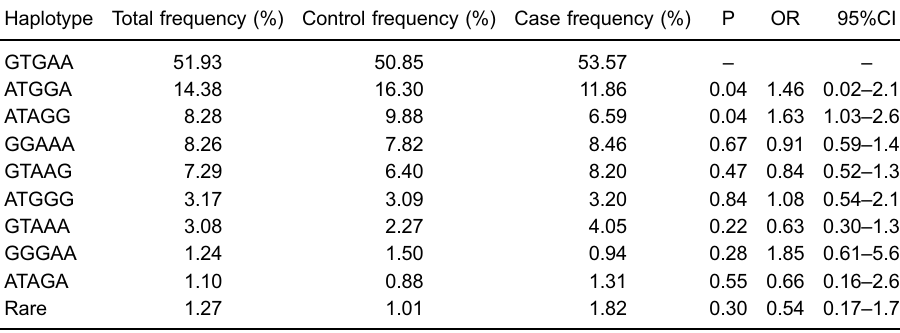
Table 4. Haplotype analyses between the two study groups.